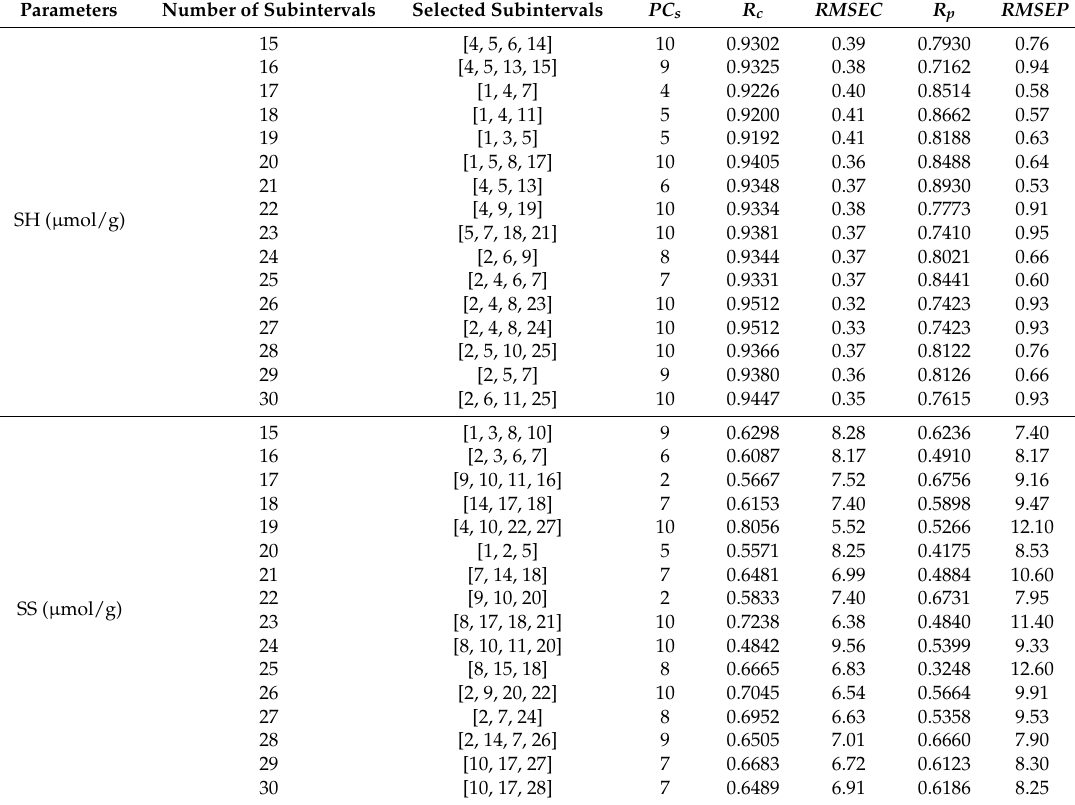
Table 1. Results of selected optimal spectral subintervals for prediction of SH and SS in in the ultrasound treatment